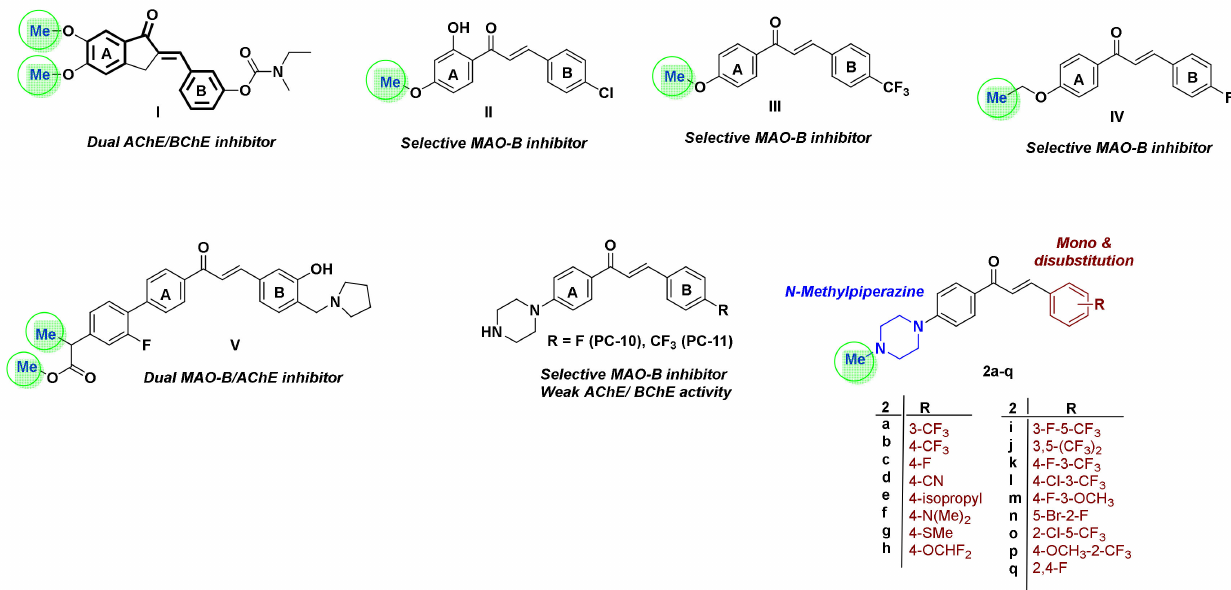
Figure 2. Representative examples of reported chalcones as selective MAO-B inhibitors or dual MAO-B/AChE or BChE inhibitors, and chemical structure of the target compounds 2k – 2q